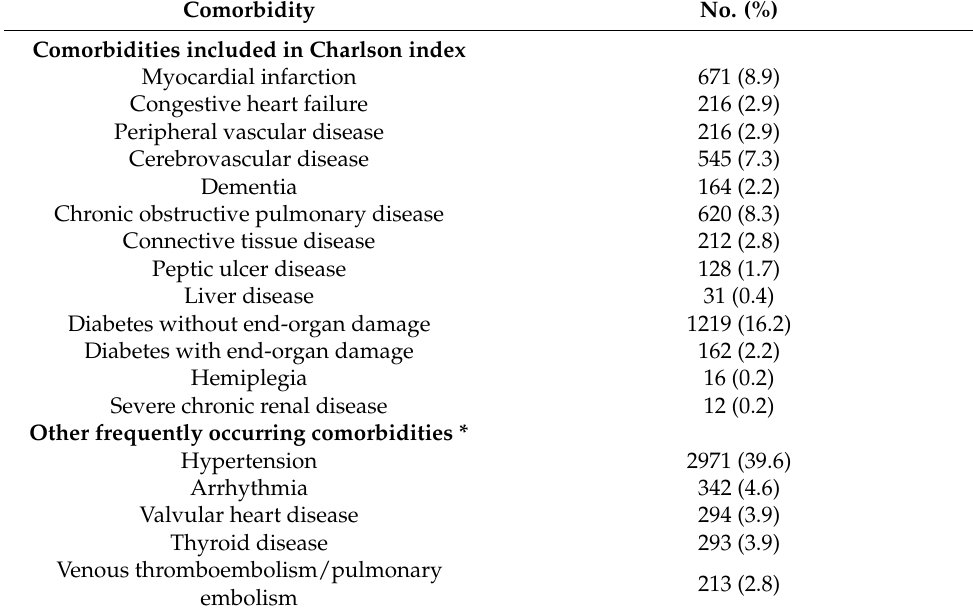
Table 2. Prevalence of specific